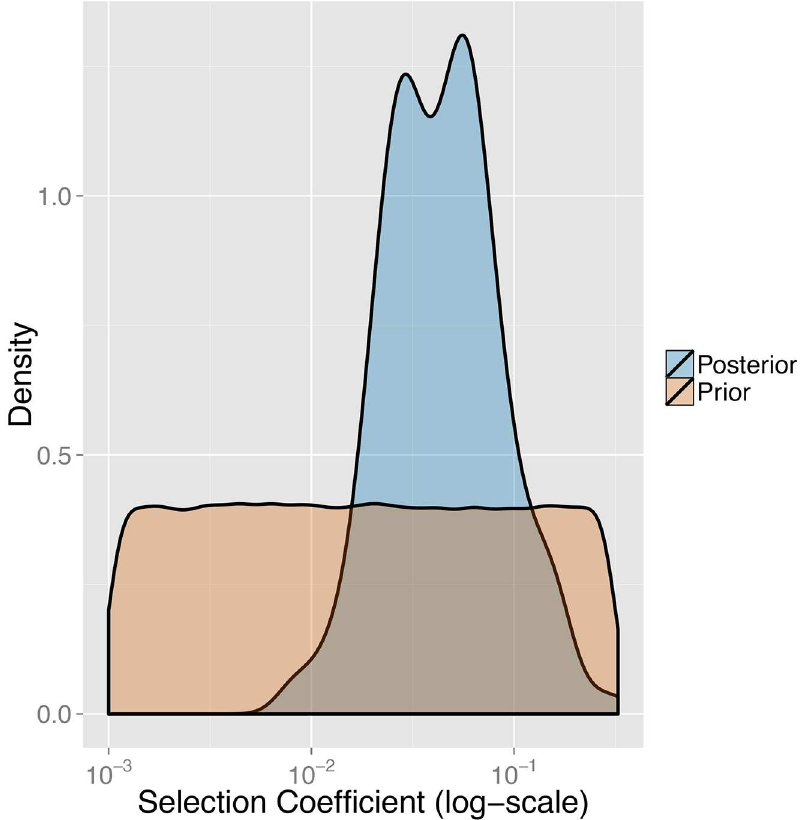
Fig 3. FY * O selection coefficient results. Prior and posterior distributionsof FY * O selectioncoefficient.